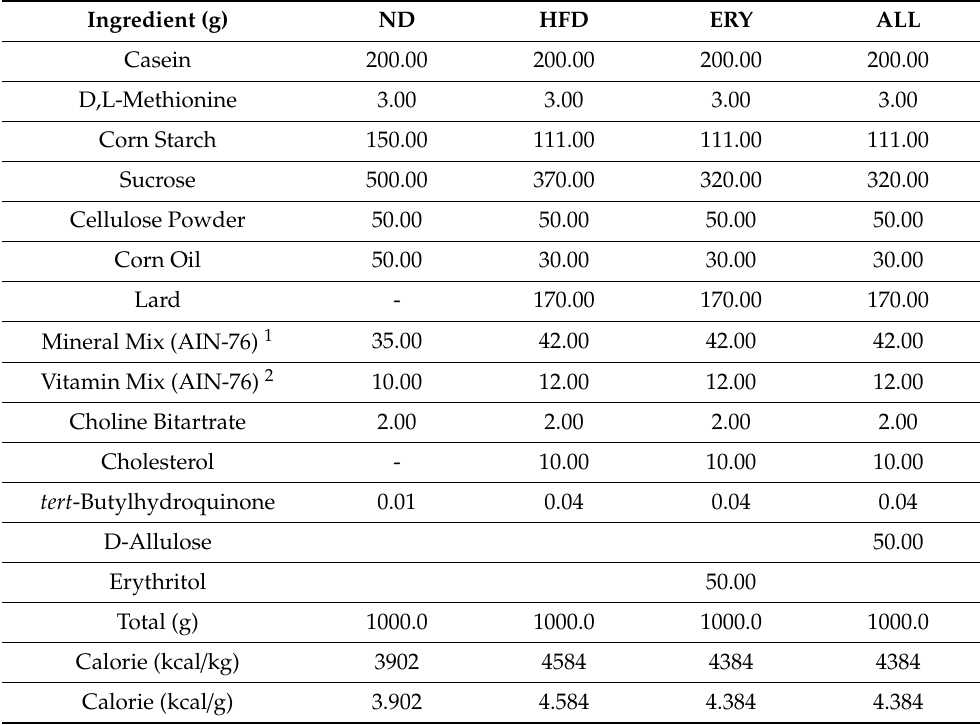
Table 1. Composition of experimental diets (% of diet, w /